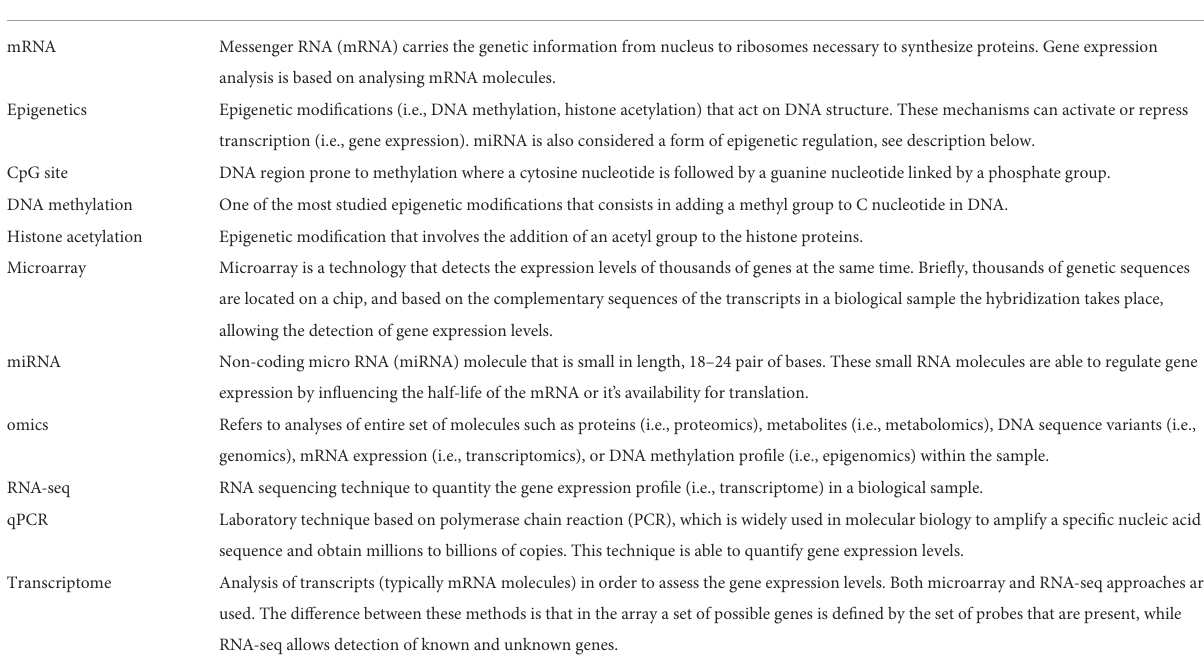
TABLE 1 Definition of the main molecular biology-related terms used in this systematic